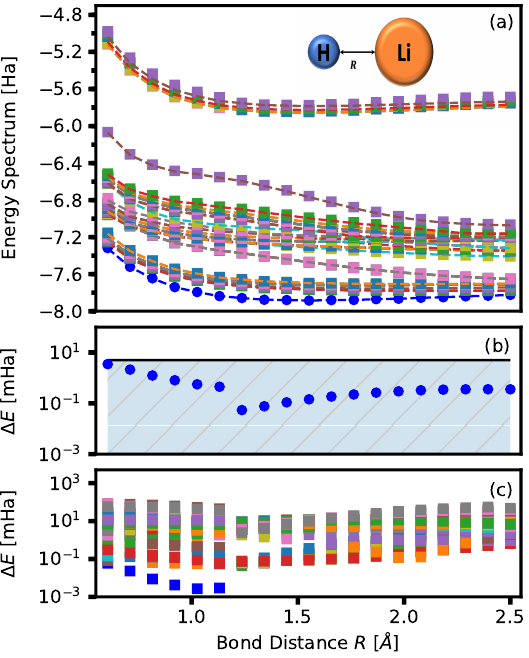
Figure 4. Similar result as shown in Figure 3 but for LiH. ( a ) Shows ground state and excited states and ( b , c ) indicate energy differences compared to exact